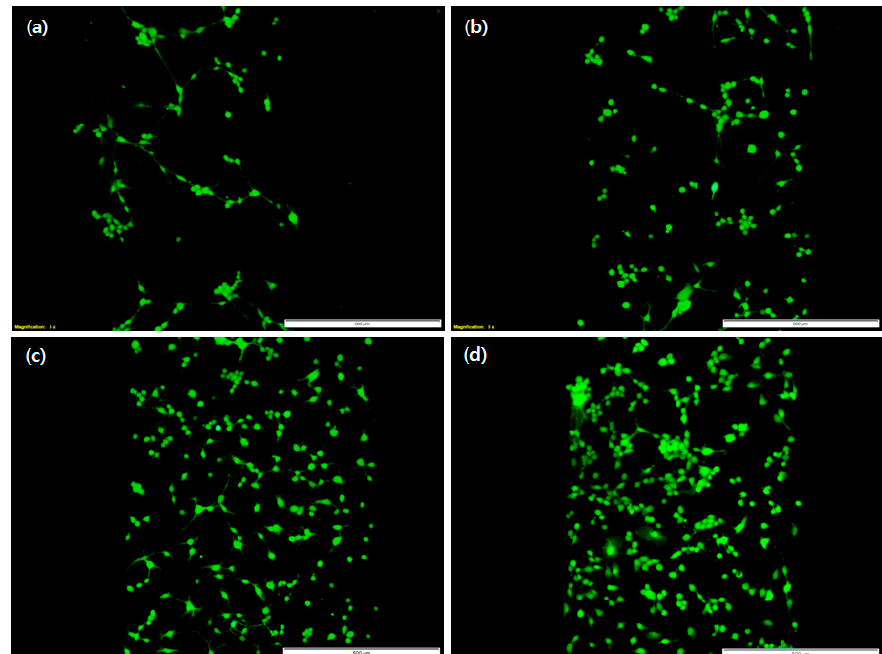
Figure 9. NIH/3T3 cell culture using the UV-curable plastic mold. Live (green) image after four days. Static culture with a channel height of ( a ) 150 μ m, ( b ) 460 μ m and ( c ) 800 μ m and ( d ) dynamic culture with a channel height of 800 μ m. Dimensions of the microchannel: 700 μ m (W) × 118 mm (L); flow rate of the dynamic culture: 4 μ L/min, Scale bar: 500 μ m.